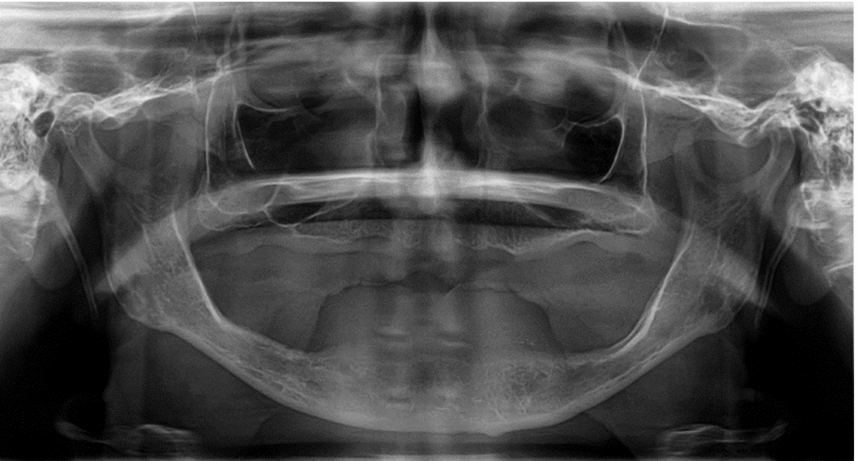
Figure 3. Panoramic radiograph of Case Vignette 2: The alveolar ridge is atrophied in both the upper and lower jaw. In the premolar and molar regions of the mandible, the bone height is insufficient. There is sufficient bone height interforaminally.